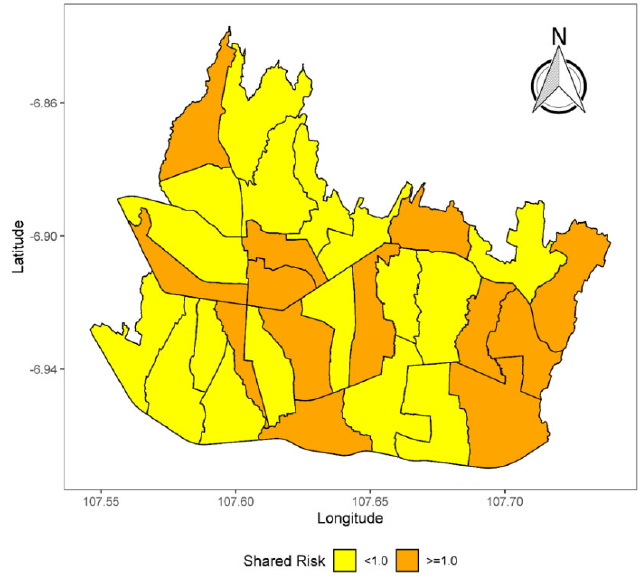
Fig. 7. Spatial endemic diseases